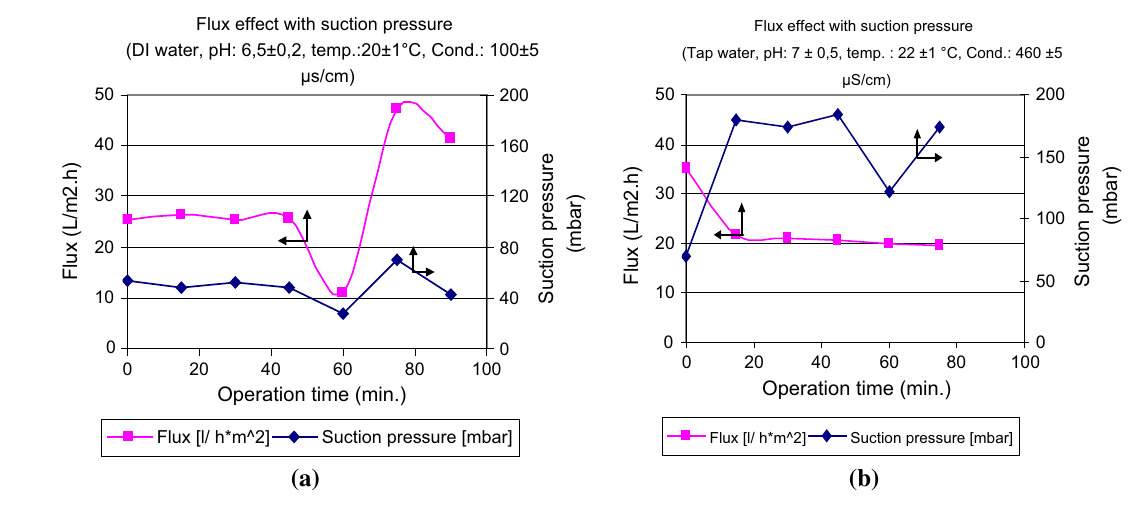
Fig. 2 Start-up results of MBR with a DI water and b tap water